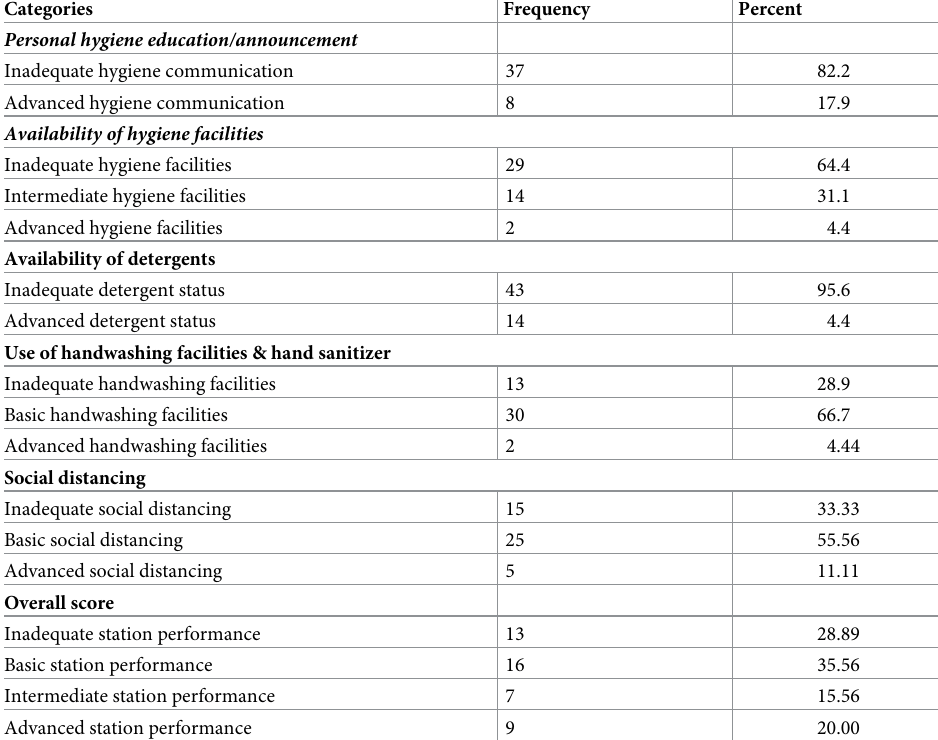
Table 6. Sectional and overall compliance of transport stations distributed by quantiles (n = 45).